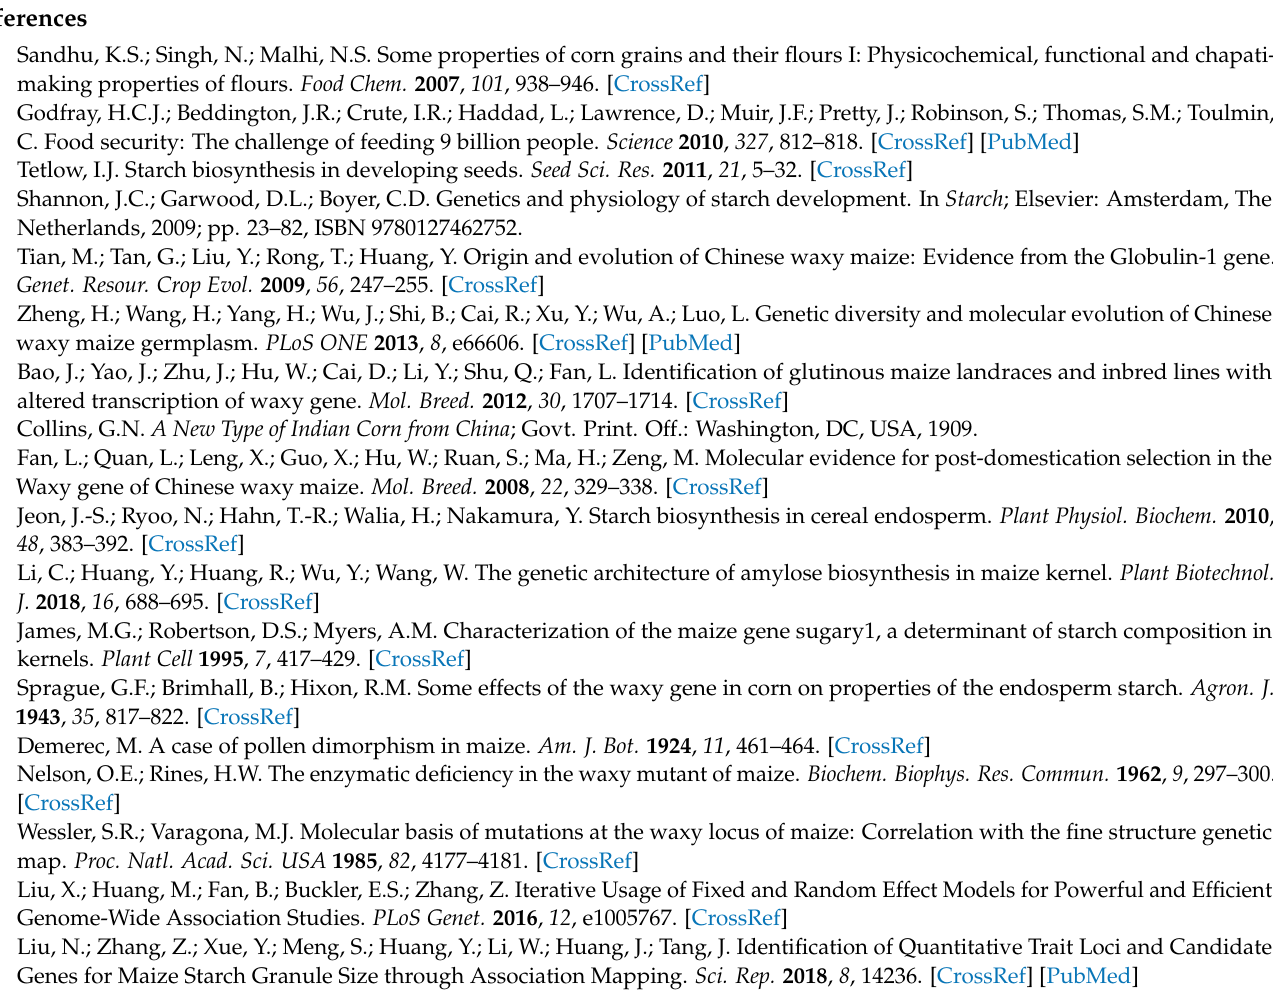
Figure S3. Frequency of the three genotypes of the SNP AX-90613979 in 213 waxy and non-waxy (field) maize lines. Table S1. List of 213 inbred and recombinant inbred lines used for GWAS analysis in this study. Table S2. List of 139 inbred and recombinant inbred lines of waxy maize and sweet maize used for marker validation. Table S3. Annotated genes within the identified QTL on chromosome